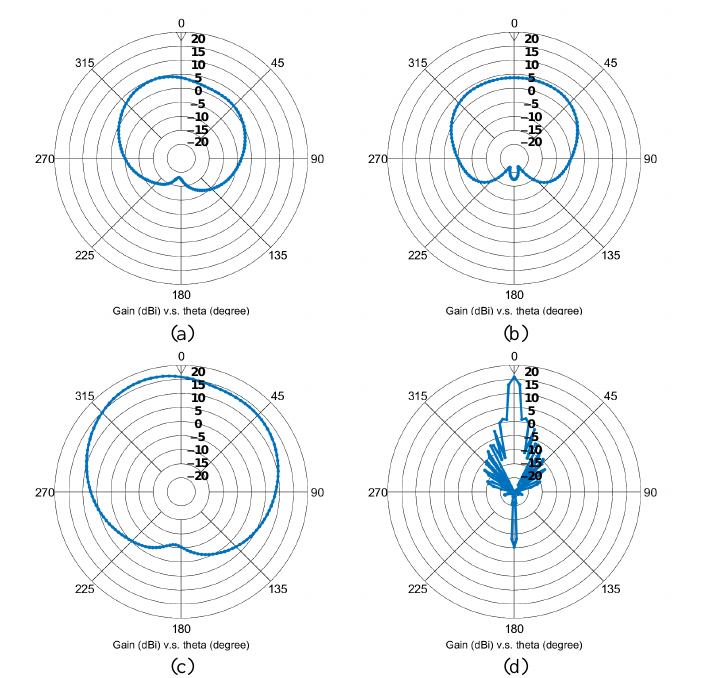
Figure 18. Simulated ( a ) E-plane and ( b ) H-plane radiation pattern for the single patch antenna; simulated ( c ) E-plane and ( d ) H-plane radiation pattern for the 16-element patch antenna